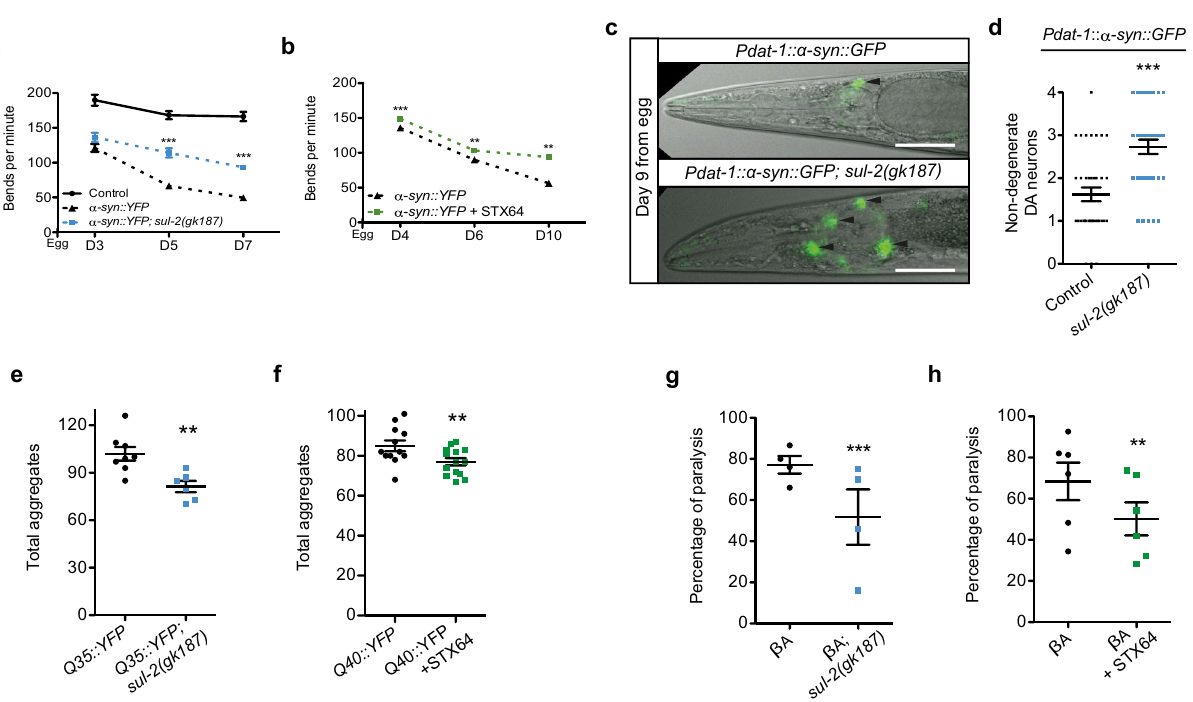
Fig. 3 Reduction of steroid hormone sulfatase activity ameliorates proteotoxicity in C. elegans . a NL5901 strain expressing α -synuclein in muscle cells reduce mobility with age at a slower rate in a sul-2(gk187) background; n ≈ 17 per sample b or under treatment with STX64 (1 μ g/ml); n ≈ 9 per sample. One of three independent biological replicates is represented in a and b , two-tailed Mann – Whitney t -test. Additional replicates assays are shown in Supplementary Fig. 8a, c. c , d Neurodegeneration of dopaminergic (DA) neurons in UA44 strain expressing human α -synuclein is reduced in sul-2(gk187) background. Animals at day 9 were imaged and the number of normal DA neurons were counted; a representative image of each condition and quanti fi cations from two biological replicates are displayed; n = 37 considering the total number of worms analysed per strain. One-tailed Mann – Whitney t -test. Scale bar represents 50 μ m. e Q35 aggregates are reduced in sul-2(gk187) background at 8-day-old worms; n ≈ 6 per strain f or by treatment with STX64 (1 μ g/ml) in Q40 background at 5-day-old worms; n ≈ 12 per strain. One-tailed unpaired t -test in e and f . g Expression of human β -amyloid in muscle provokes a thermodependent paralysis in L4-young adult stage in GMC101 strain; the paralysis phenotype is ameliorated in sul-2 deletion mutant. Data display the percentages from four independent biological replicates; n = 125 per strain h or by STX64 (1 μ g/ml) treatment. Data display the percentages from six independent biological replicates; n ≈ 215 per strain. χ 2 test was used to analyse the data in g and h . In all graphs mean ± SEM are displayed. ** p ≤ 0.01, *** p ≤ 0.001. Exact n and p value are included in Source Data fi